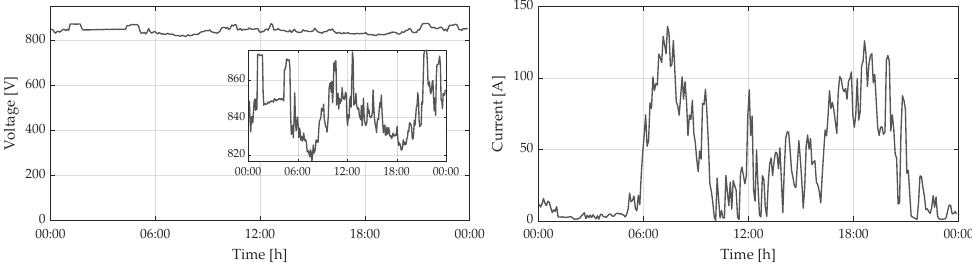
Figure 9. Voltage ( left ) and current ( right ) measurements in TS T-T in an average window of 5 min. The plots cover a 24-h simulation